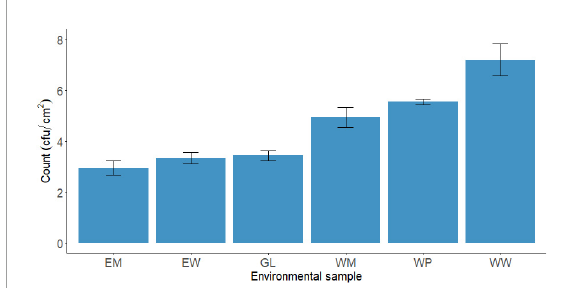
FIGURE1 Total bacterial count (TBC) on environmental samples collected at the processing plant. EM, walls, maturation room; EW, walls, warm room; GL, gloves of workers, packaging area; WM, drains, maturation room; WP, drains, packaging area; WW, drains, warm room (mean ± standard deviation of six